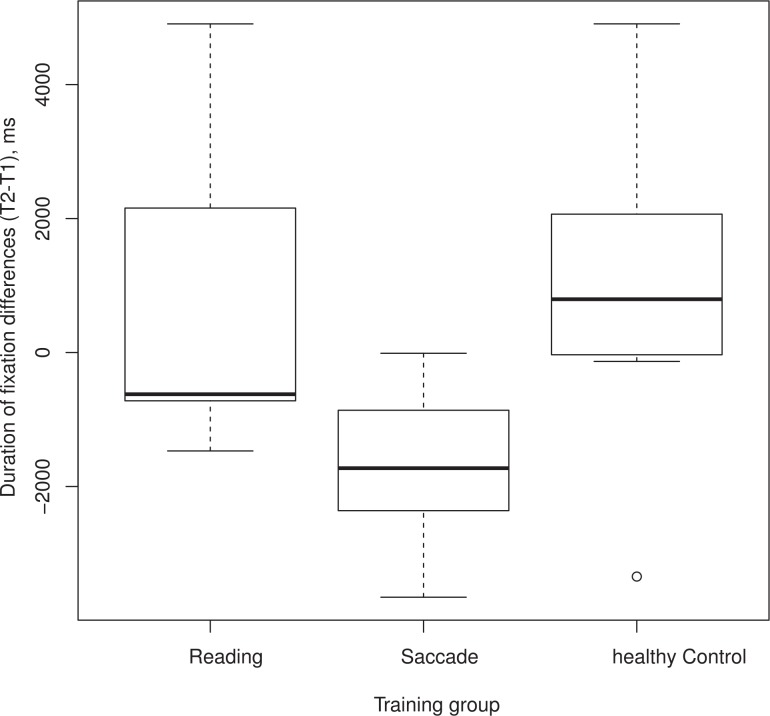
Box plot comparison of patients’ eye movements with healthy control observers before (T1) and after (T2) training.The abscissa represents the three training groups (reading, saccade or healthy control). The ordinate shows the duration of fixations for each training group, calculated as differences between the durations of fixations performed after and before training (T2-T1). Negative numbers indicate that fixation durations were shorter after training.